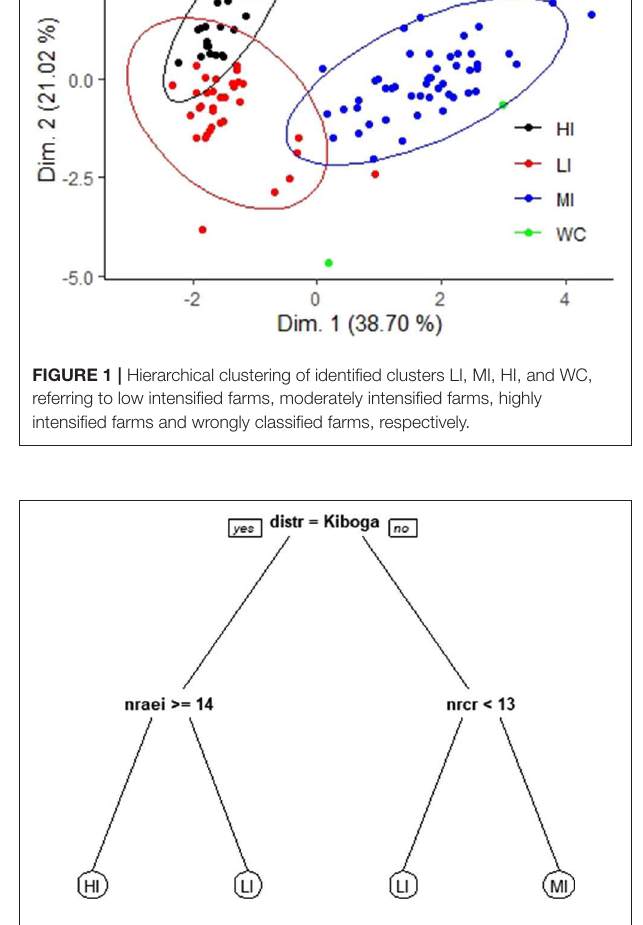
FIGURE 2 | Classification tree, with overall accuracy of 82%, to classify the two observations from cluster WC into the three remaining clusters (LI, MI, and HI, referring to low, moderately, and highly intensified farms). Distr represents the considered district, nraei the number of applied agroecological intensification practices and nrcr the number of cultivated crop